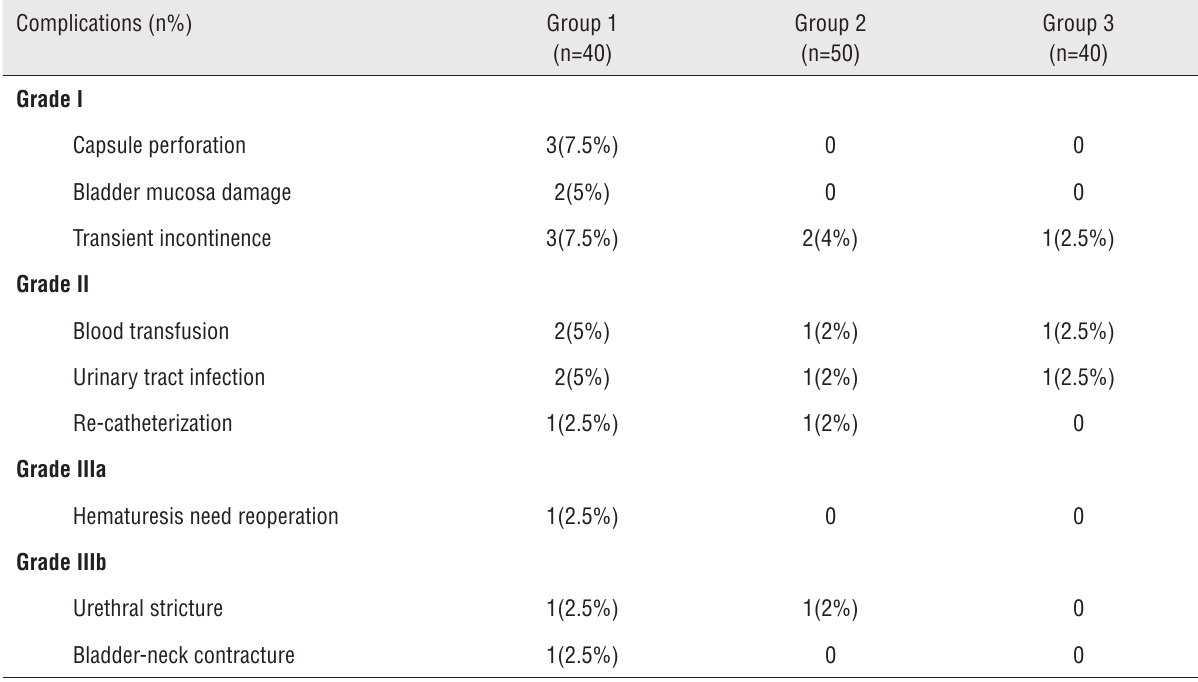
Table 3 - Complications of PKERP according to the CLAvIEN-DINDO grade